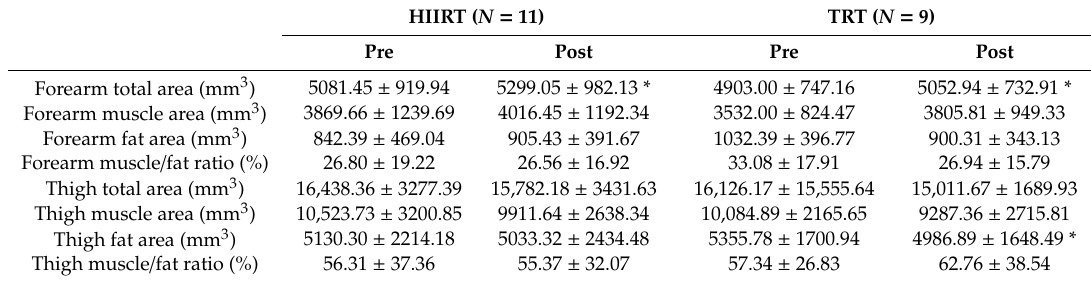
Table 2. Muscle area measurements via peripheral quantitative computed tomography (pQCT) scan.